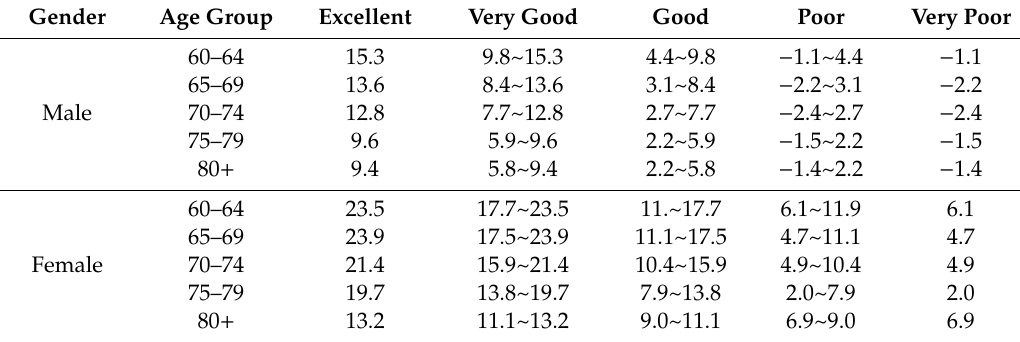
Table 17. Sit and reach 5-grade relative evaluation norms, Unit: